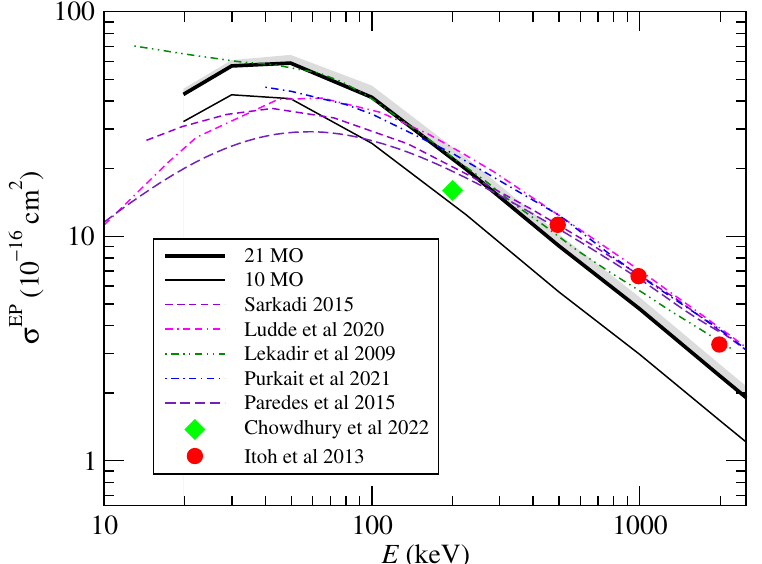
Figure 8. Total cross sections for electron production in proton–uracil collisions as functions of the collision energy. The present CTMC results (solid lines marked with 21 MO and 10 MO) are compared with those of previous calculations Paredes et al. [9], Lüdde et al. [11], Lekadir et al. [12], Sarkadi [13], and the experimental results of Itoh et al. [3] and Chowdhury et al. [4],as indicated in the figure. An estimation of the Auger contribution to ionization is added with a gray